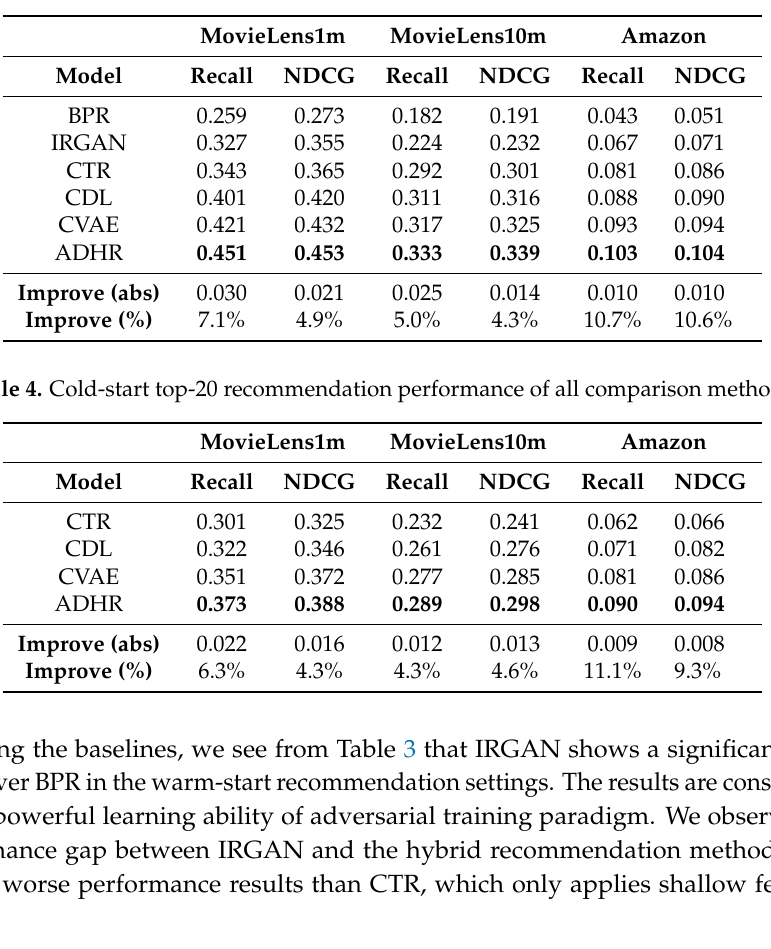
Table 3. Warm-start top-20 recommendation performance of all comparison methods.